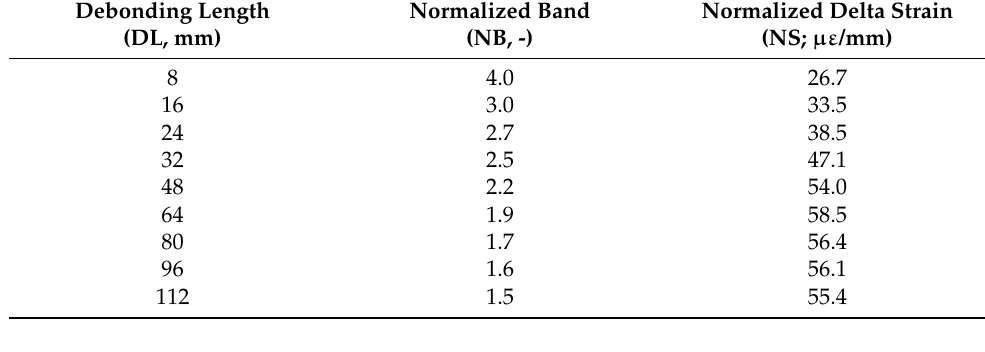
Table 5. Characteristic parameters vs. debonding length.